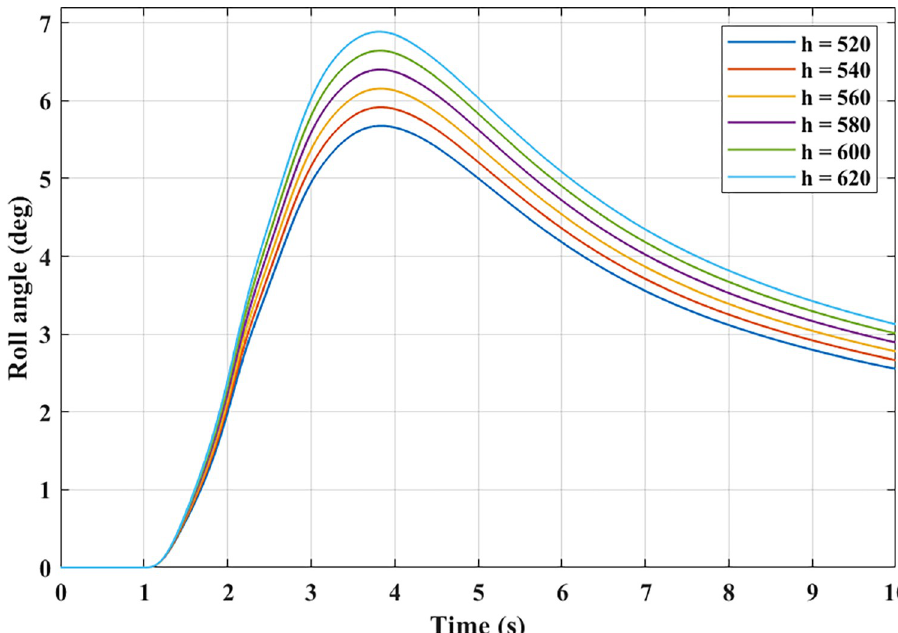
Fig 10. The relationship between height and roll